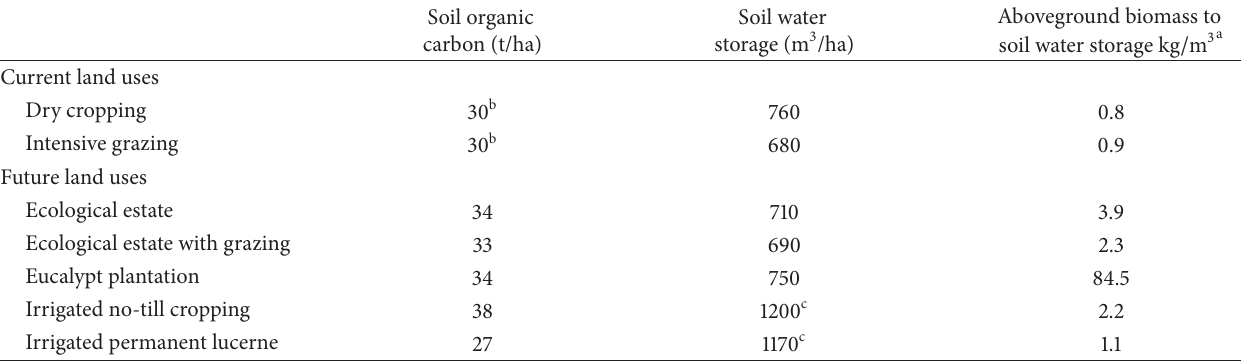
Table 2: Predicted service indicators under both current and new land uses for a predominant clay soil in the study landscape. Values were derived from 25-year simulations based on average properties of the clay soil to 30 cm